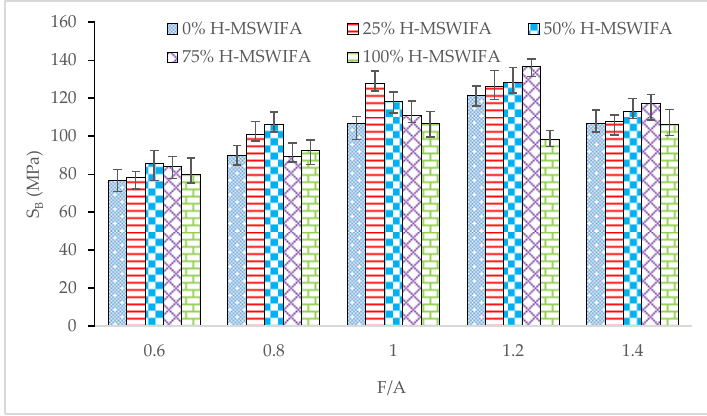
Figure 6. Test results of S B .